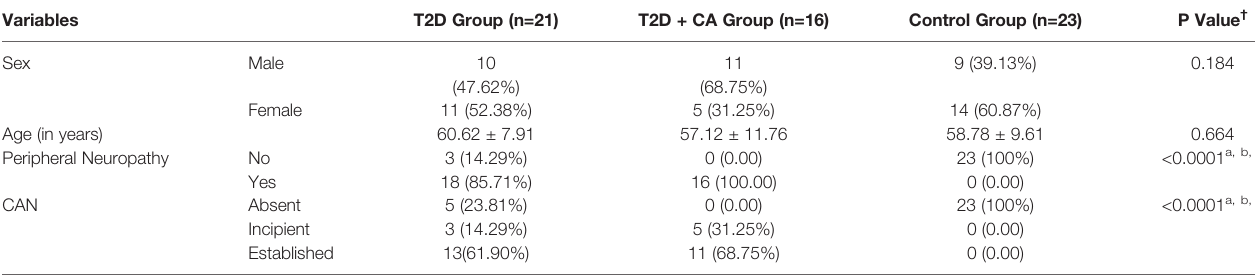
TABLE 1 | Comparative analysis among the groups of type 2 diabetes (T2D) patients with Charcot arthropathy (CA), type 2 diabetes patients without CA, and healthy individuals according to autonomic and peripheral neuropathies. Variables